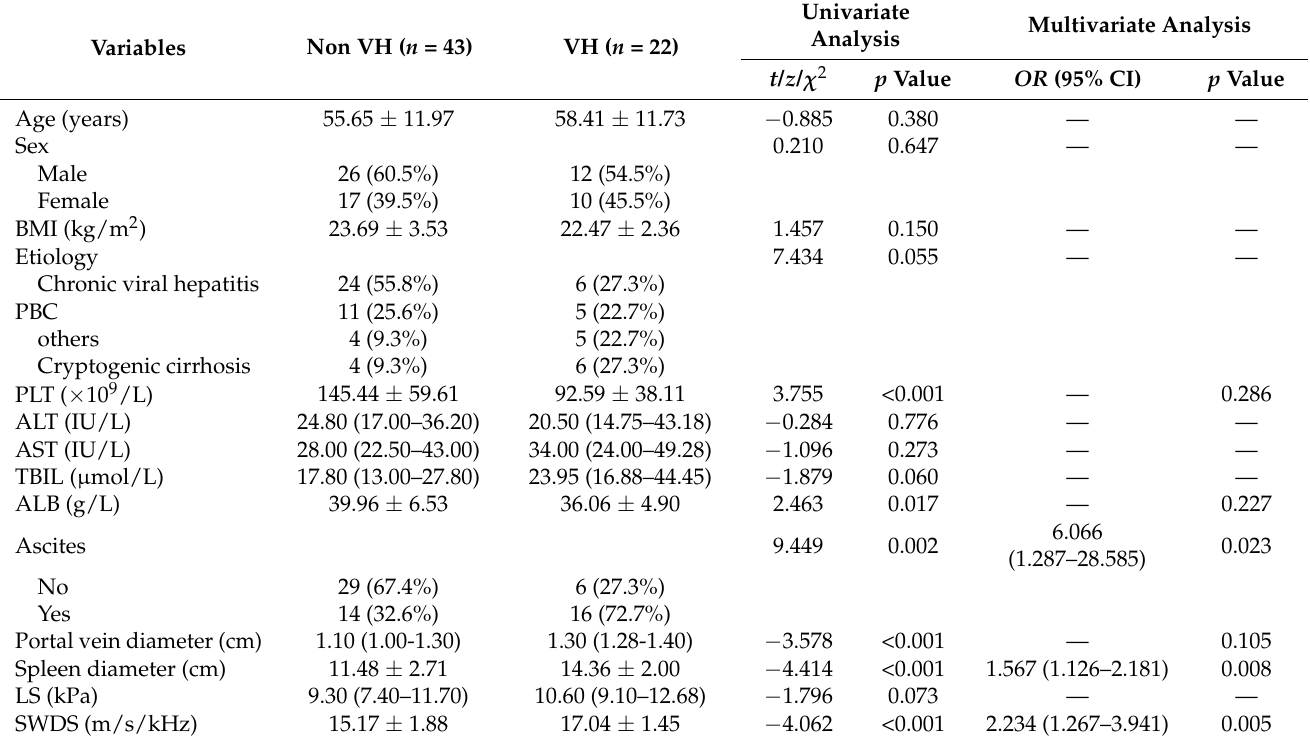
Table 1. Clinical and Ultrasound Characteristics of the